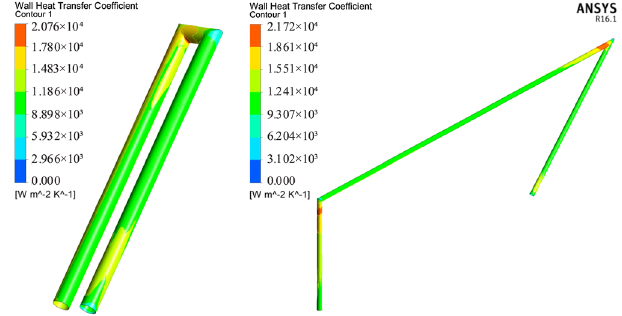
FIG. 27. The simulated heat transfer coefficient distribution.